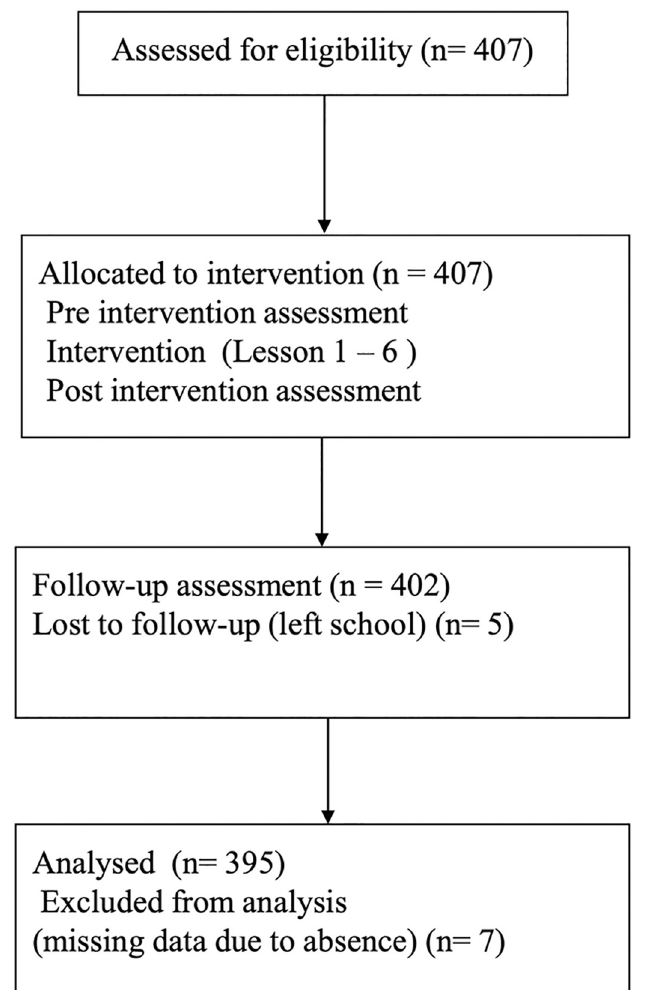
Fig 1. Flowchart of the resilience education